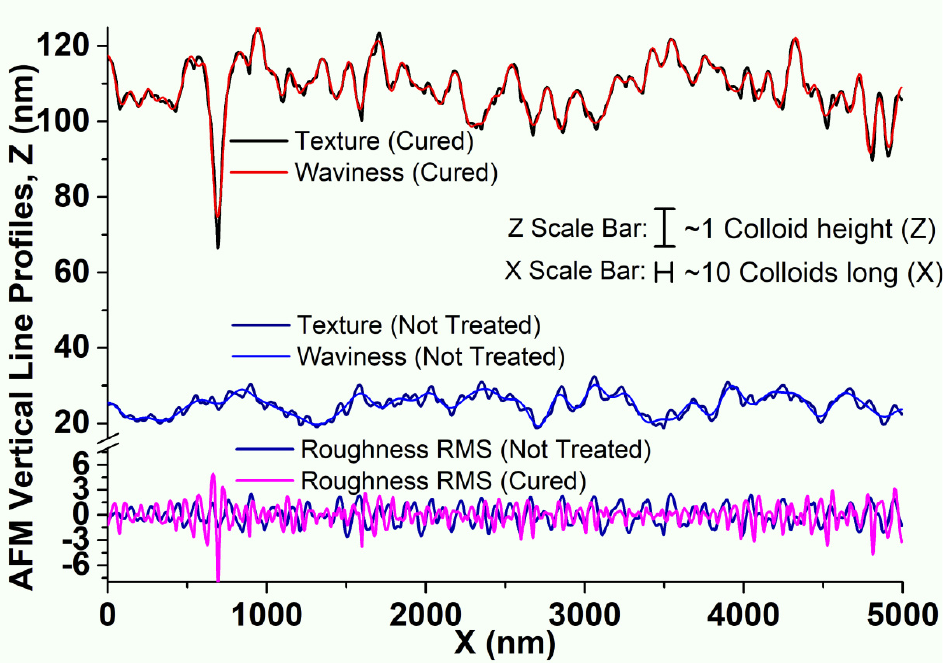
Figure 12. AFM profiles of a 210 nm thick (AR 1  ) film cured and not treated with texture, wavi- ness, and roughness. and